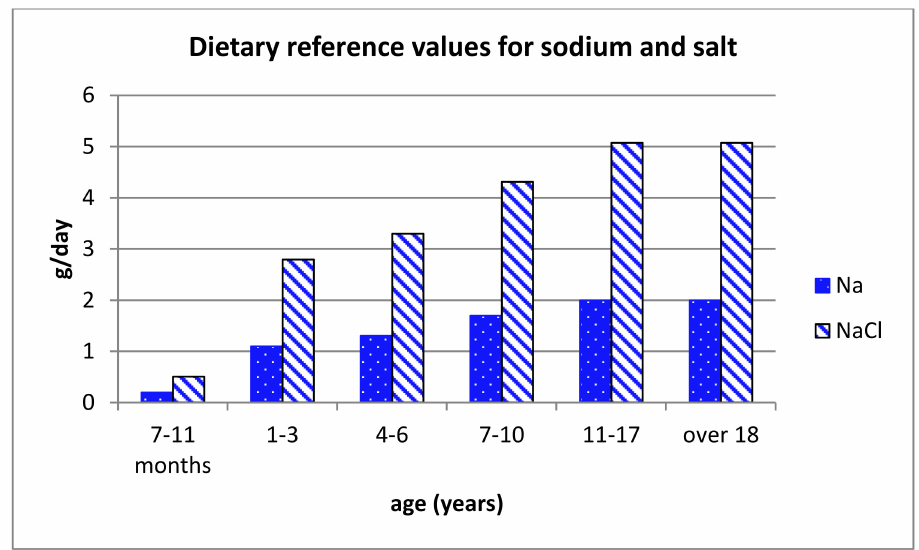
Figure 1. Sodium and salt dietary reference values for children and adults [3].